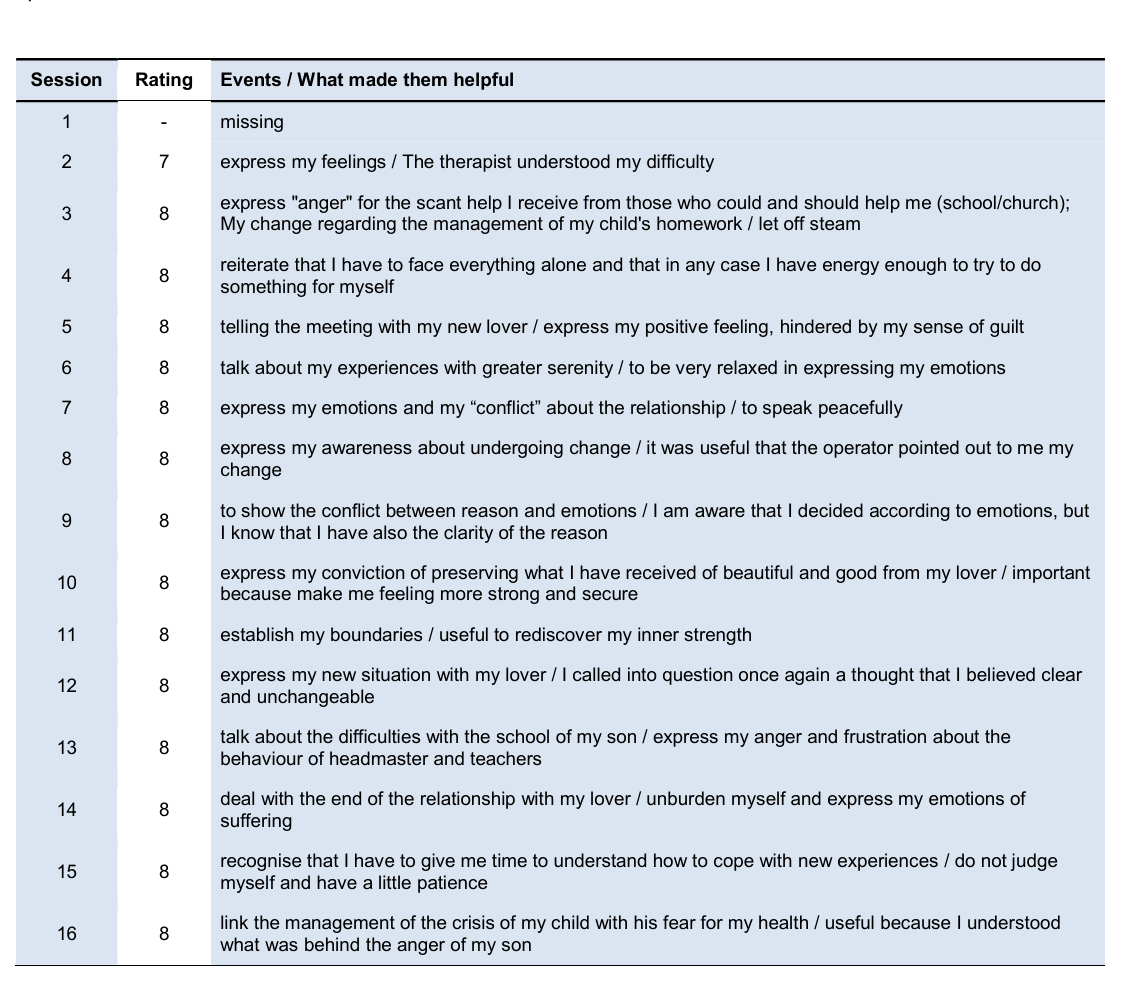
Figure 3: Therapist's weekly evaluation of Penelope depression - HAM-D score Note. 0A and 0B = assessment sessions. HAM-D = Hamilton Depression Rating Scale (Hamilton, 1960). FU = follow- up.